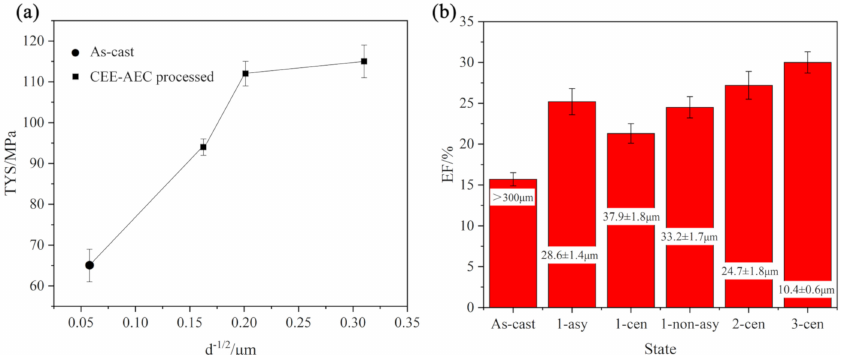
Figure 14. Schematic illustration of ( a ) the relationship between TYS and d-1 / 2, and ( b ) the EF of di ff erent sampling positions with di ff erent